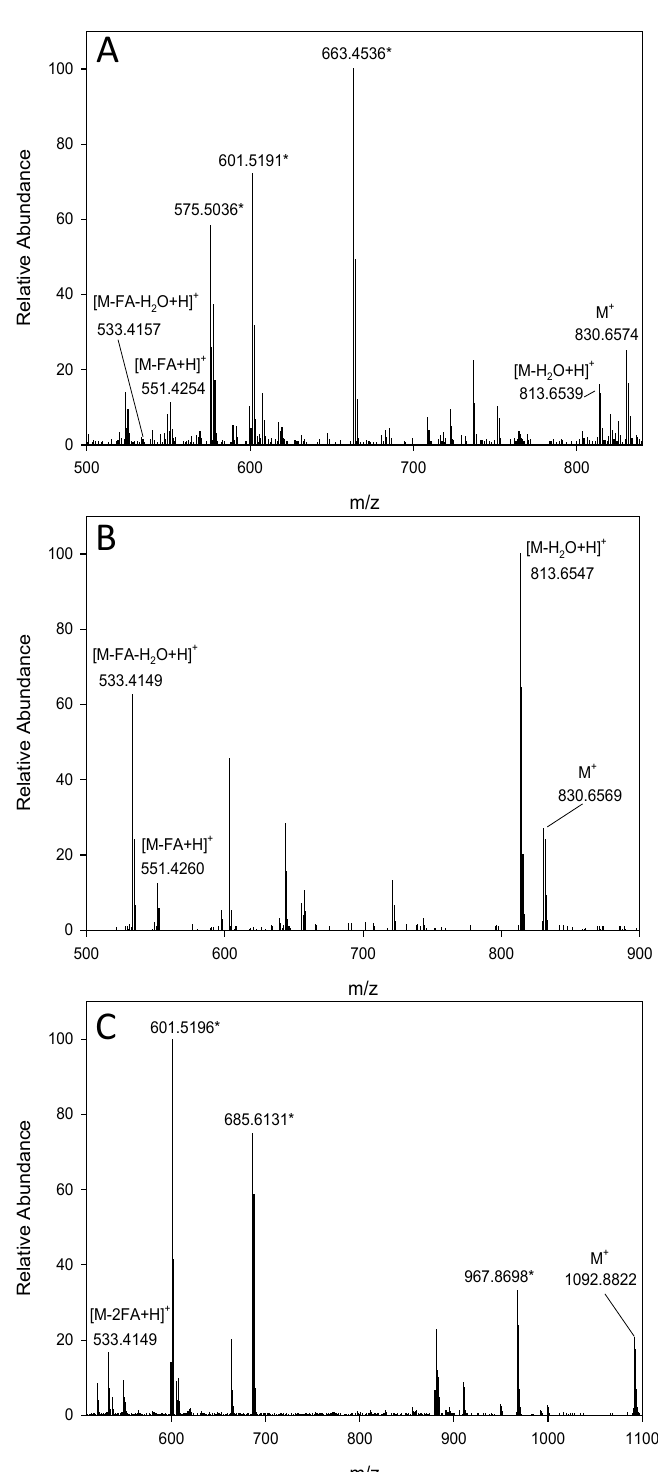
Figure 3. MS spectra of trans-lutein mono- and di-esters identified in canary seed samples in positive ionization modes, ( A ) trans-lutein-3 (cid:48) -O-linoleate (ESI), ( B ) trans-lutein-3-O-linoleate (APCI), ( C ) trans- lutein-dilinoleate (APCI). * Major non-carotenoid